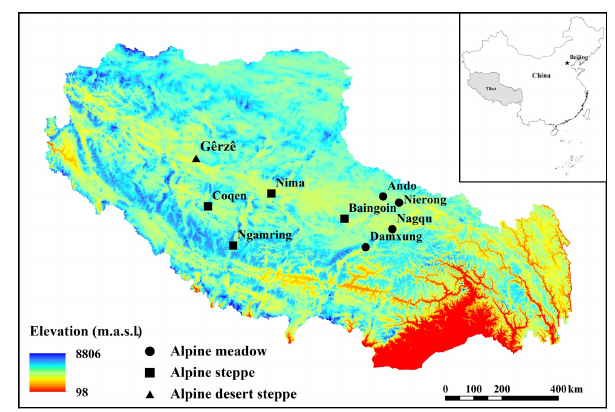
Figure 1. Location of study area and distribution of sampling sites of alpine